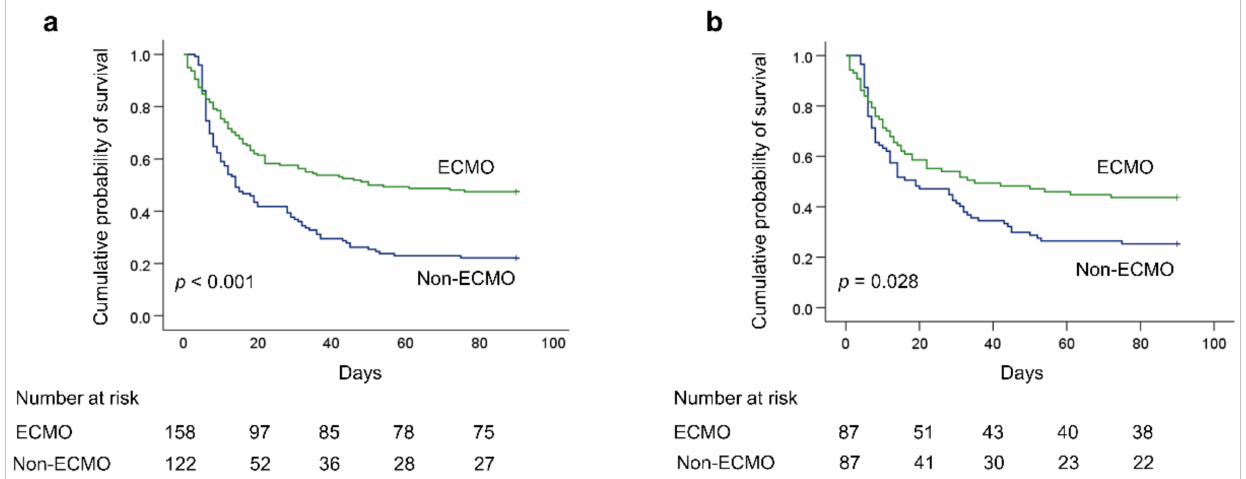
Figure 2. Kaplan-Meier 90-d survival curves of patients who did or did not receive ECMO support for severe acute respira- tory distress syndrome: ( a ) before propensity score matching; ( b ) after propensity score matching. (ECMO, extracorporeal membrane oxygenation). Table 2. Clinical outcomes of severe ARDS patients with or without ECMO after matching. Outcomes ECMO Non-ECMO p ( n = 87) ( n = 87) Mortality 28 day hospital mortality, n (%)